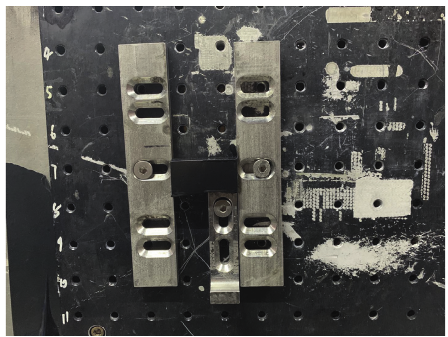
Figure 18: Schematic of Ni-based alloy GH4169 clamping.